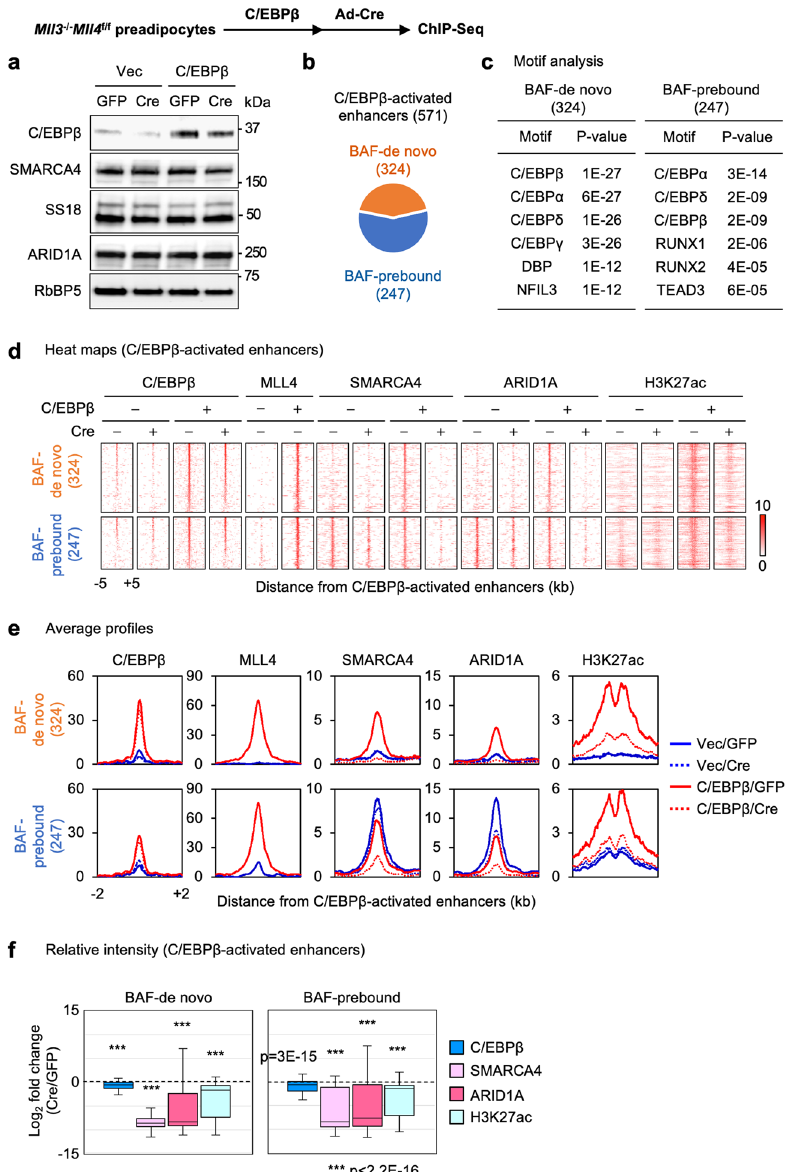
Fig. 7 MLL4 is required for BAF binding on C/EBP β -activated enhancers. Mll3 ‒ / ‒ Mll4 f/f brown preadipocytes were infected with retroviruses expressing C/EBP β or vector (Vec), and then infected with adenoviruses expressing GFP or Cre. Sub-con fl uent cells were collected without inducing adipogenesis for Western blot and ChIP-Seq analyses. Published ChIP-Seq data sets for C/EBP β , MLL4, H3K27ac were used (GSE50466) 14 . a Western blot analyses of BAF subunits (SMARCA4, SS18, and ARID1A) and C/EBP β expression in control (GFP) and Mll4 KO (Cre) preadipocytes. n = 2 biological replicates. b Among the 571 C/EBP β -activated enhancers in preadipocytes, BAF (SMARCA4 and ARID1A) binding was induced on 324 AEs only after ectopic expression of C/ EBP β (BAF-de novo), while 247 AEs were already bound by BAF before ectopic expression of C/EBP β in preadipocytes (BAF-prebound). c Motif analysis of BAF-de novo and BAF-prebound AEs using SeqPos motif tool. d – f Deletion of Mll4 reduces BAF binding on C/EBP β -activated enhancers. Heat maps ( d ) and average pro fi les ( e ) around C/EBP β -activated enhancers are shown. Enhancers shown in the heat maps were ranked by the intensity of C/EBP β at the center in control cells expressing ectopic C/EBP β . f Fold changes of intensities between control and Mll4 KO (Cre) cells on BAF-de novo ( n = 324) and BAF-prebound ( n = 247) C/EBP β -activated enhancers are shown in box plots. The box represents the fi rst and third quartiles with the horizontal line showing the median, and whiskers indicating minimum and maximum in all box plots. Outliers were not included. Statistical signi fi cance levels are as follows (Wilcoxon signed rank test, one-sided): BAF-de novo C/EBP β ( p = 1.3E-19); BAF-de novo SMARCA4 ( p = 1.1E-51); BAF-de novo ARID1A ( p = 4.1E- 50); BAF-de novo H3K27ac ( p = 1.1E-48); BAF-prebound C/EBP β ( p = 2.9E-15); BAF-prebound SMARCA4 ( p = 1.0E-32); BAF-prebound ARID1A ( p